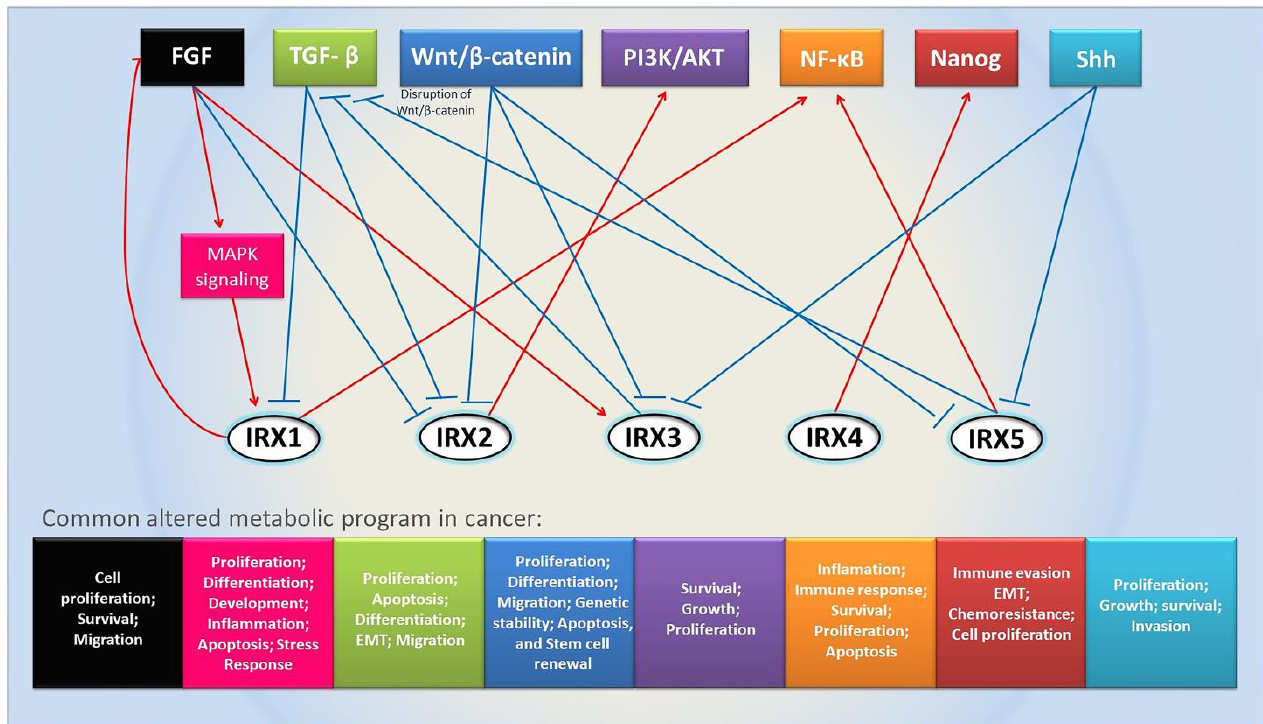
Figure 2. Important signaling pathways related to Iroquois family genes. Arrows indicate a rela- tionship between pathways and Iroquois genes. Blue arrows indicate inhibition, and red arrows indicate activation.